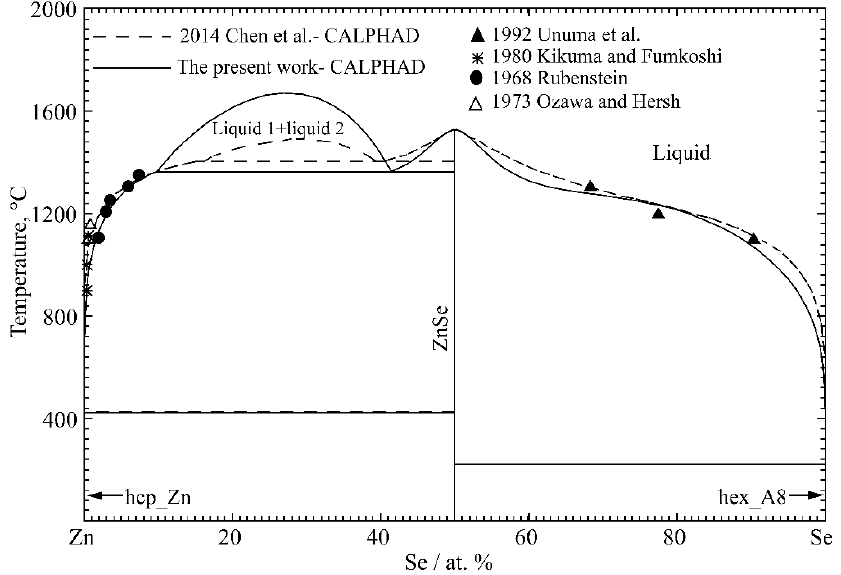
Figure 15. The calculated phase diagram of the Zn-Se system compared with the experimental data from refs. [108,109,111,113] and previously optimized results by Chen et al. [125].